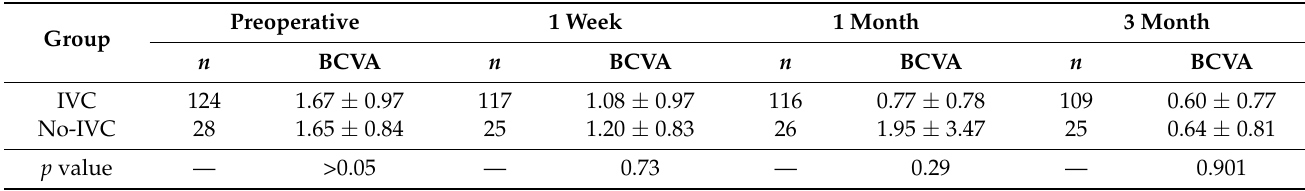
Table 8. BCVA changes between two